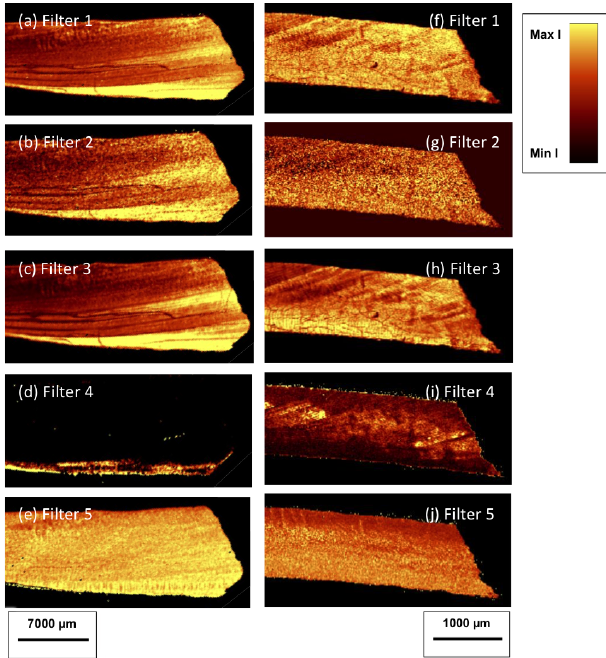
Figure 6. Images extracted from the filters applied to the Ra- man spectra (see Fig. 5) from samples G171 ( S. biradiata ) (a– e) and G155 ( F. tenuicostata ) (f–j) . Scale bar: 7000µm (a–e) and 1000µm (f–j) . Colour scale: the bright colours correspond to high intensities (high CCD counts) and the dark colours correspond to low intensities (low CCD counts). The sub-horizontal and curved lines, most visible in (a–c) and (f–h) , are structural features of the shells. Scale bar: 500µm.